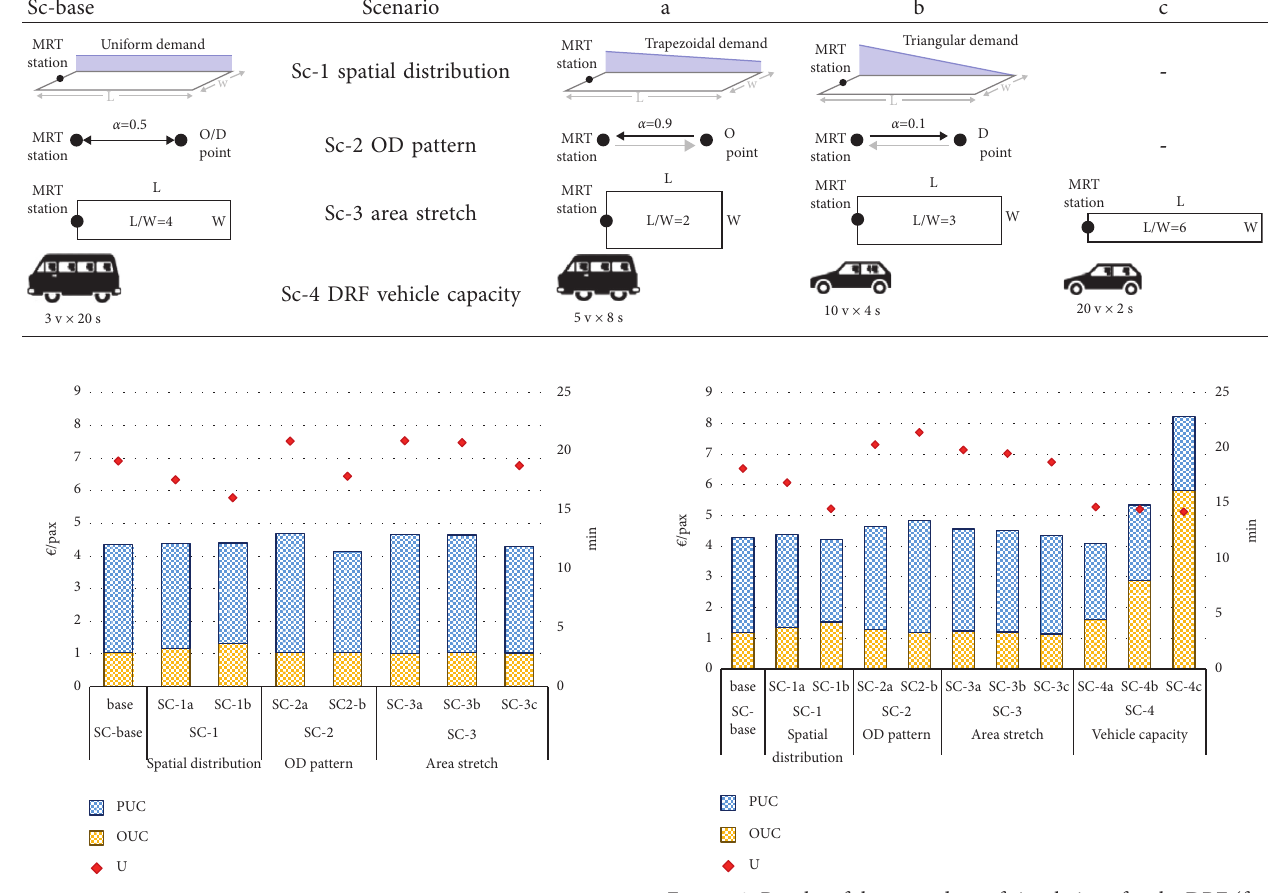
Figure 8: Results of the second set of simulations for the FRF (for result interpretation; PUC � passenger unit cost; OUC � operator unit cost; U � utility).